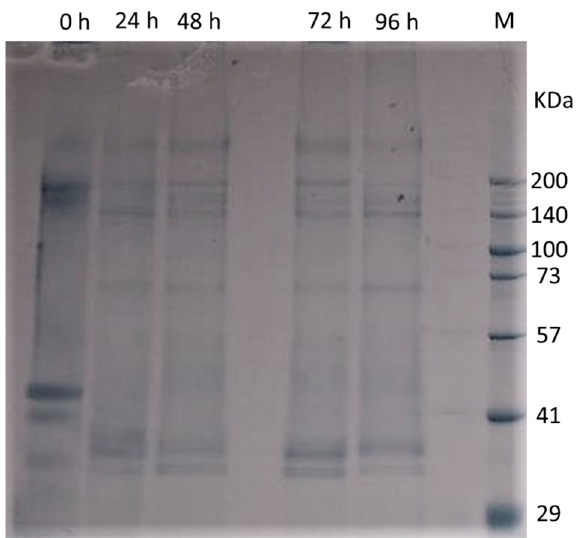
Figure 6. SDS-PAGE analysis of mixtures of internal organs of white sturgeon reacted at 50 °C for 96 h. M, protein molecular weight standards.